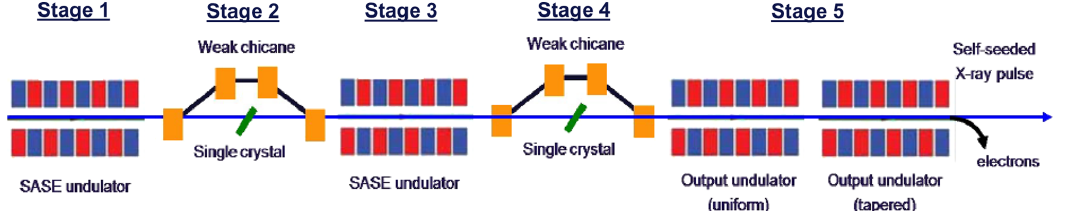
section.FIG. 3. The two-chicane HXRSS configuration at the European